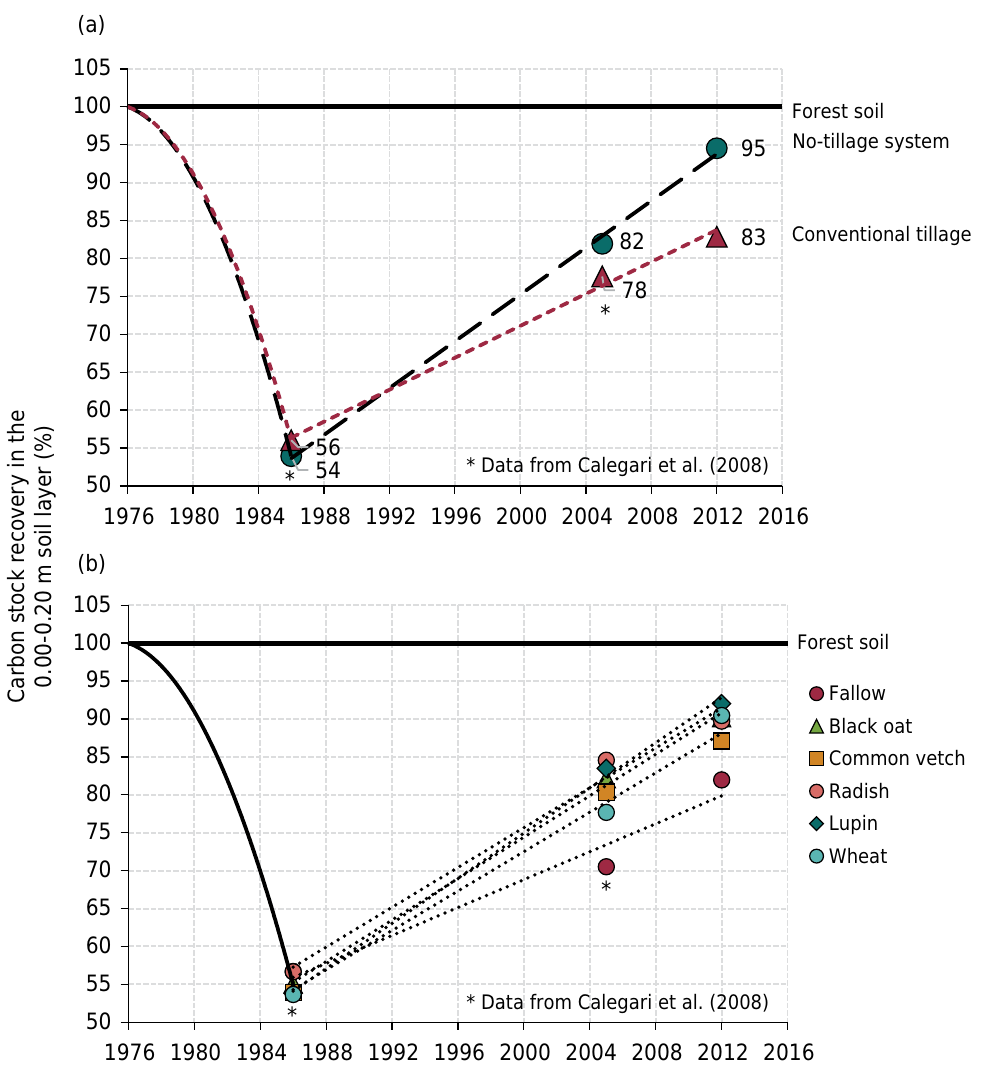
Figure 3. Carbon stock recovery in the 0.00-0.20 m soil layer after forest clearing (1976) for intensive cultivation with soil plowing (from 1976-1986), at the beginning of the experiment (1986), and at 19 and 26-years after as affected by soil management system (a) and winter cover crops treatments (b).